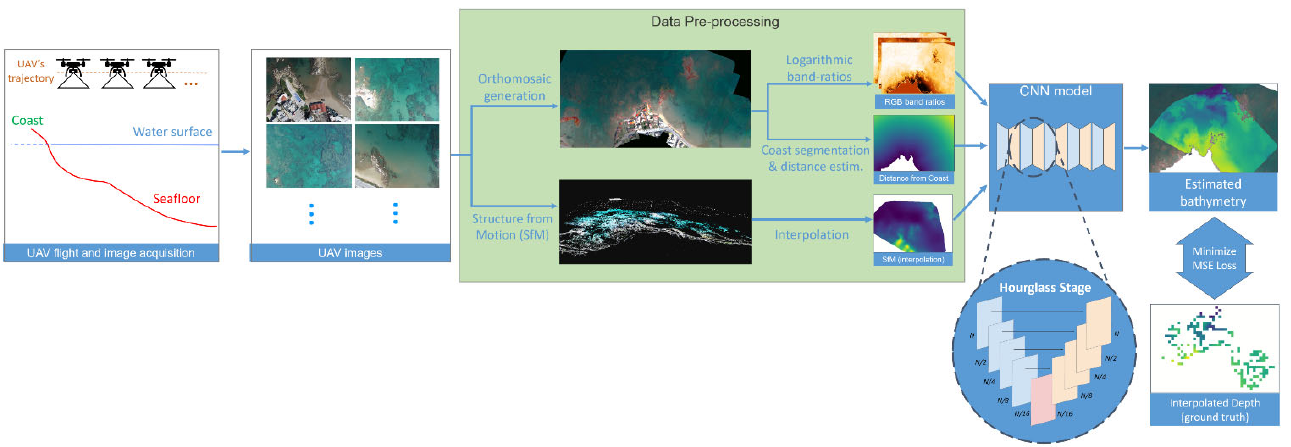
Figure 3. Overall workflow of the proposed approach for drone-based bathymetry estimation. The images acquired by the drone are processed to generate an orthomosaic of the study area, as well as to perform Structure from Motion. Then, logarithmic RGB band ratios are calculated, as well as a map with the distance from coast and a rough depth estimate derived from interpolating the SfM result. These are then fed to the adopted CNN model, which consists of convolutional layers (light blue), deconvolutional layers (light orange), and a bottle-neck convolution (light red). The layers inside a stage fluctuate the inputs in dimensions N (spatial and feature). The outputs of all stages contribute to minimizing the loss function between the estimations and the interpolated USV